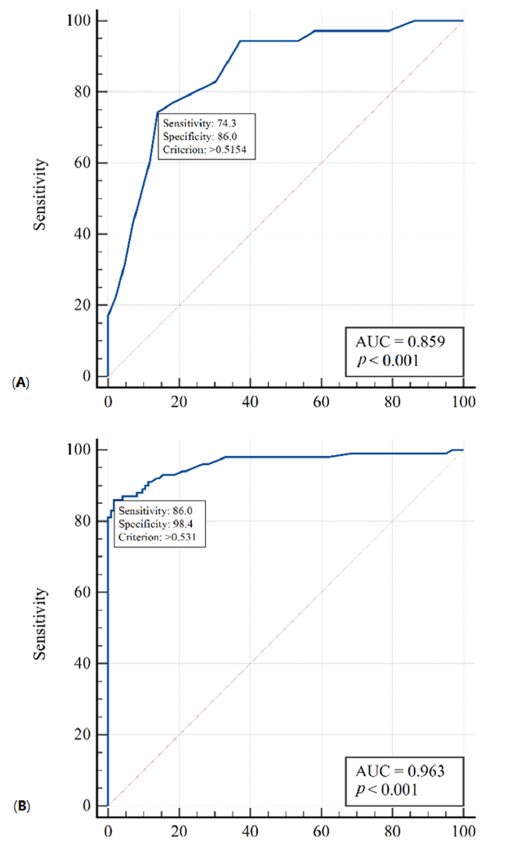
Figure 2. ROC curves (multivariate logistic regression models) for predicting mortality risk. ( A ): a model using procalcitonin for the Delta group. ( B ): a five ‐ factor model using IL ‐ 6, fibrinogen, leu ‐ kocytes, thrombocytes, and procalcitonin for the non ‐ Delta